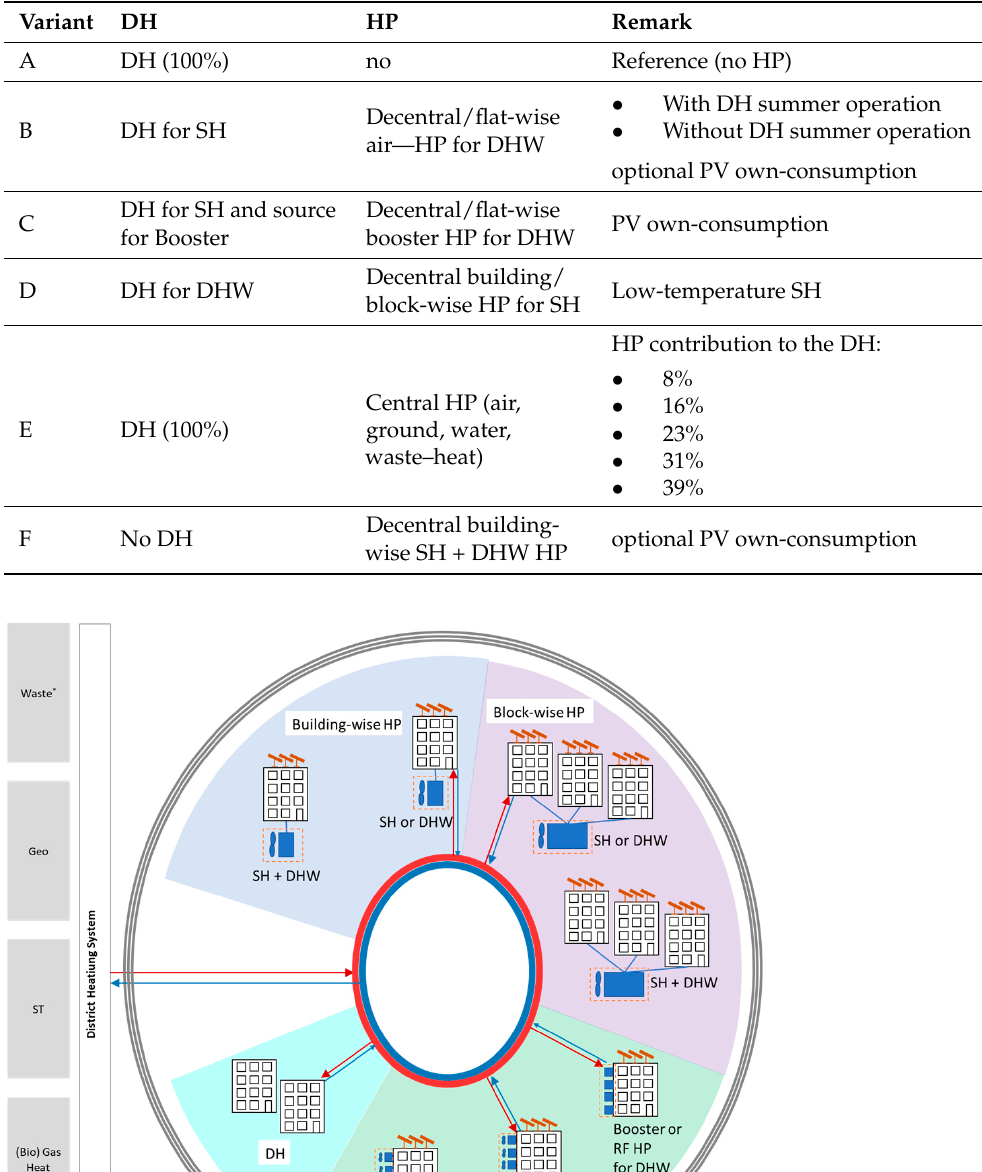
Table 4. Overview of DH and HP integration options, see also Section 1.3.